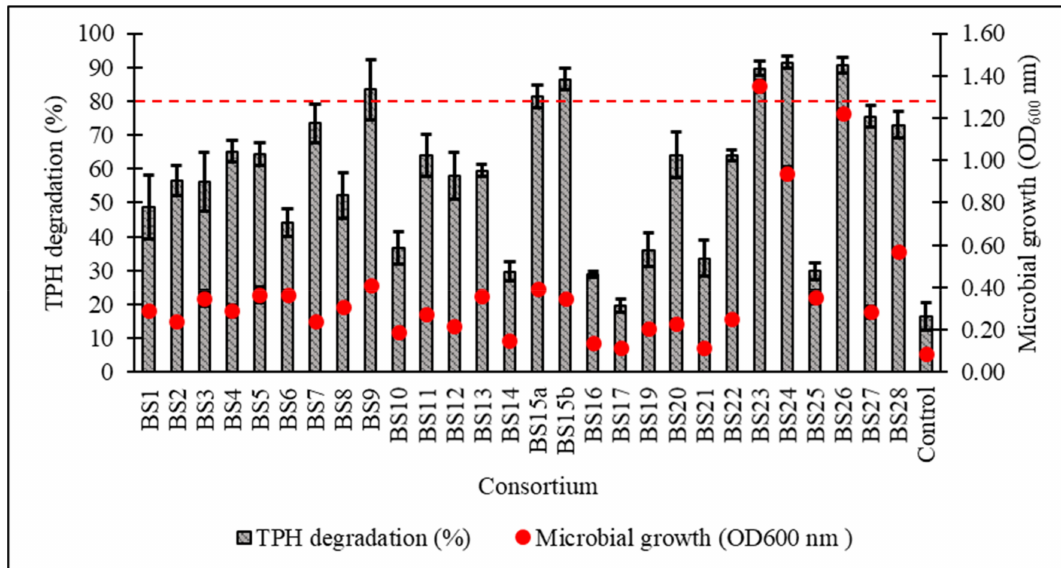
Figure 2. Percentage degradation of total petroleum hydrocarbons (TPH) and microbial growth (as OD 600 ) after 7-day incubation in standardised Bushnell-Haas (BH) broth enriched with 1% v / v initial diesel concentration. The dotted red line indicates ≥ 80% TPH degradation capacity. Error bars represent the mean ± standard deviation for experimental triplicates.